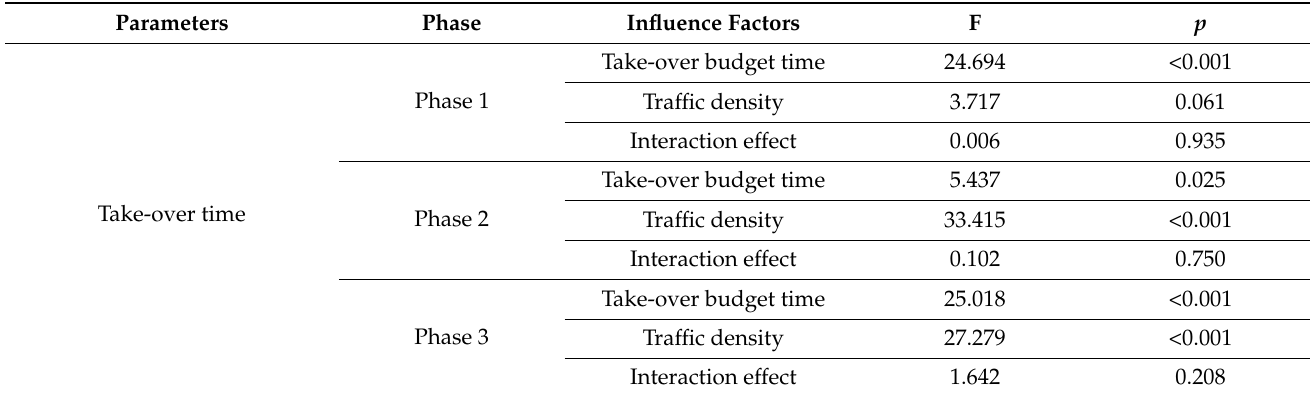
Table 6. Influence of take-over budget time and traffic density on take-over